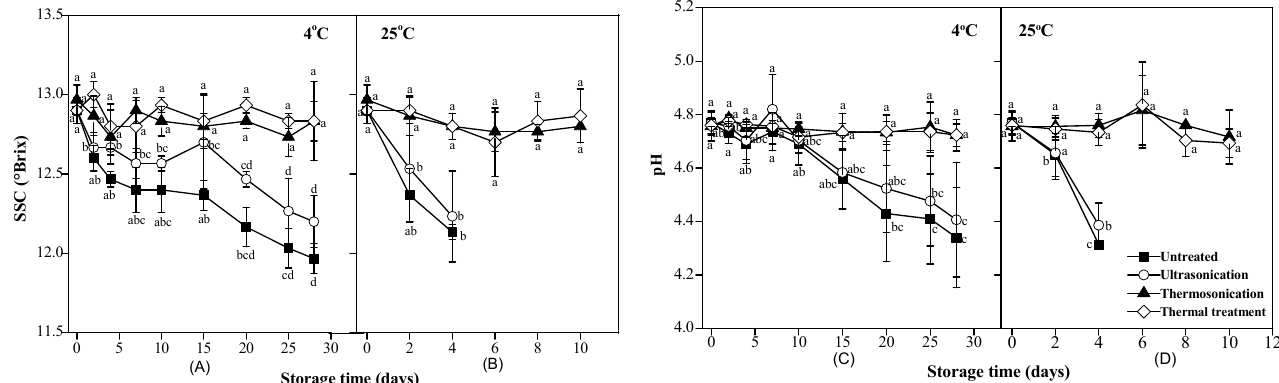
Figure 3. Variance of soluble solid content (( A ), samples stored at 4 ◦ C; ( B ), samples stored at 25 ◦ C) and pH values (( C ), samples stored at 4 ◦ C; ( D ), samples stored at 25 ◦ C) in red pitaya juices during storage at 4 ◦ C and 25 ◦ C, as subjected to thermosonication (475 W, 56 ◦ C, 20 min), ultrasonication (475 W, 10 ◦ C, 20 min), and thermal (83 ◦ C, 1.5 min) treatments, a, b, c, d means significant difference o f SSC or pH values with respect to storage time ( p < 0.05).